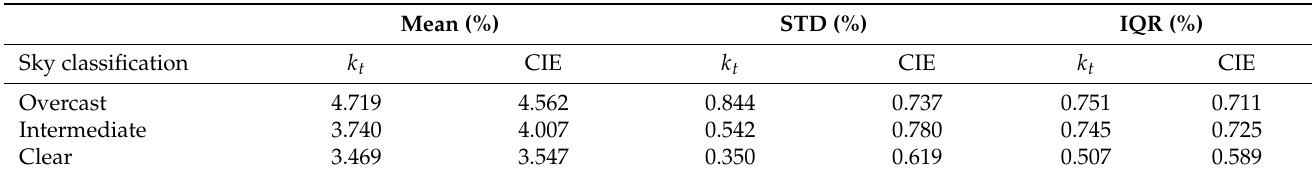
Table 6. Mean, standard deviation (STD), and interquartile range (IQR) of the GHUV/GHI average values (%), based on the 10 min datasets for clear, intermediate, and overcast sky types, which were classified according to the k t and CIE criteria.